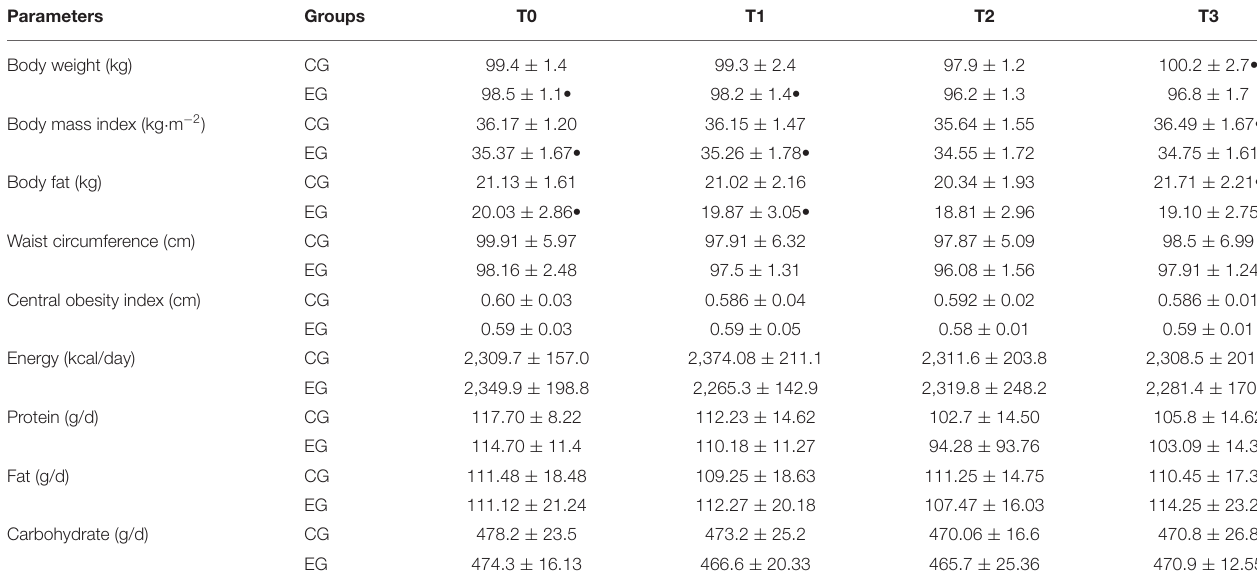
TABLE 1 | Body composition characteristics and macronutrient values (mean ± SD) of the experimental group (EG, n = 12) and control group (CG, n = 12) measured before the start of Ramadan (T0), on the 15th day of Ramadan (T1), at the end of Ramadan (T2) and after Ramadan (T3). Parameters